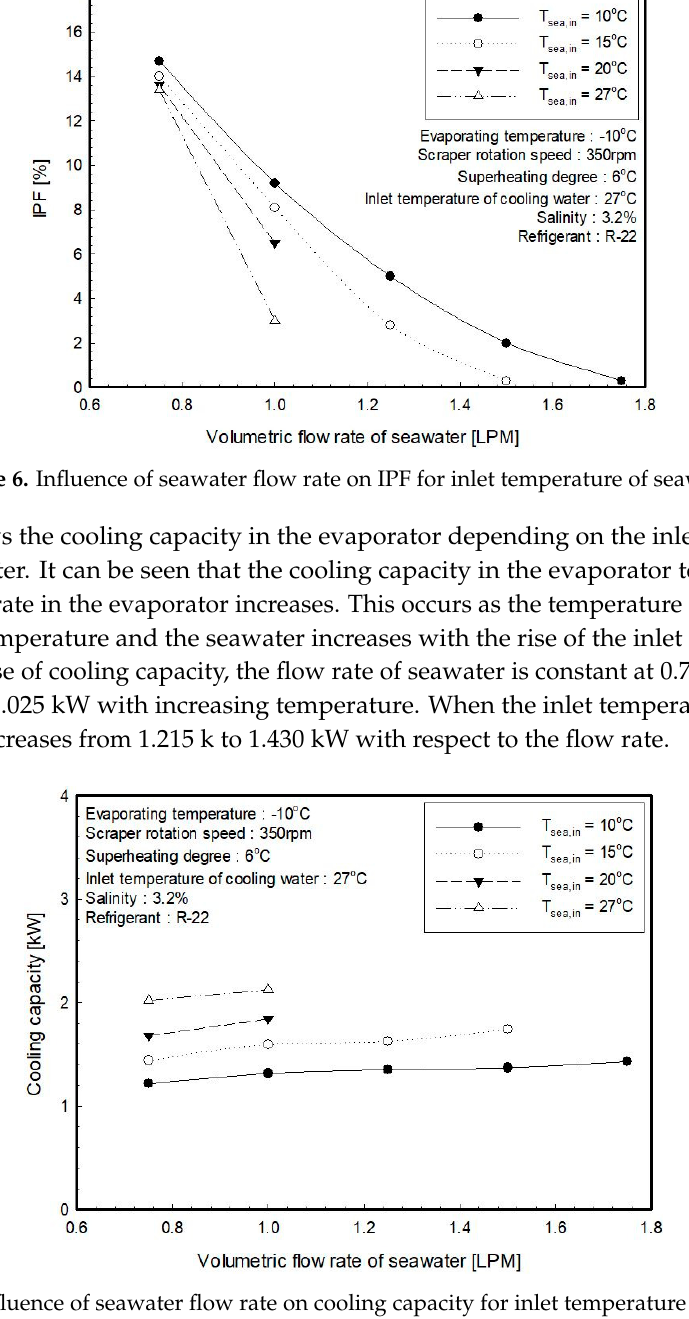
Figure 7. Influence of seawater flow rate on cooling capacity for inlet temperature of seawater.